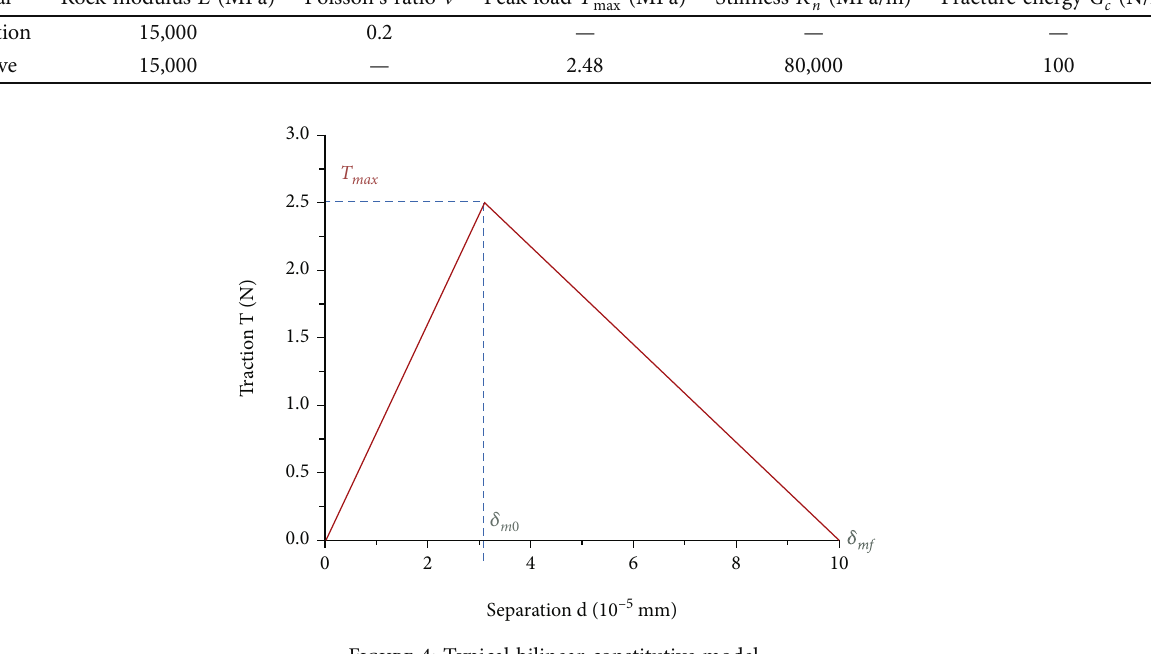
Figure 4: Typical bilinear constitutive